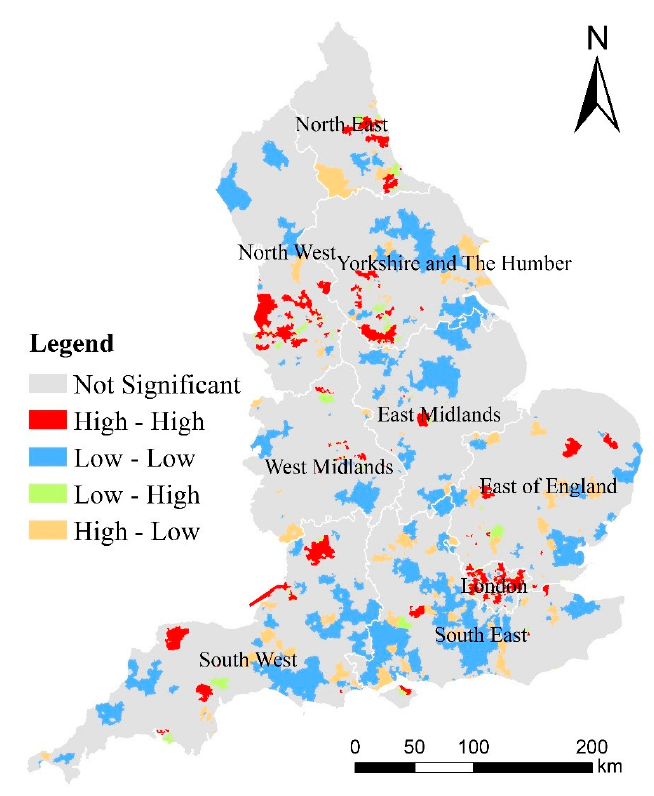
Figure 4. Clusters and outliers of MSOA-level “percentage of obese children” across the regions of England.